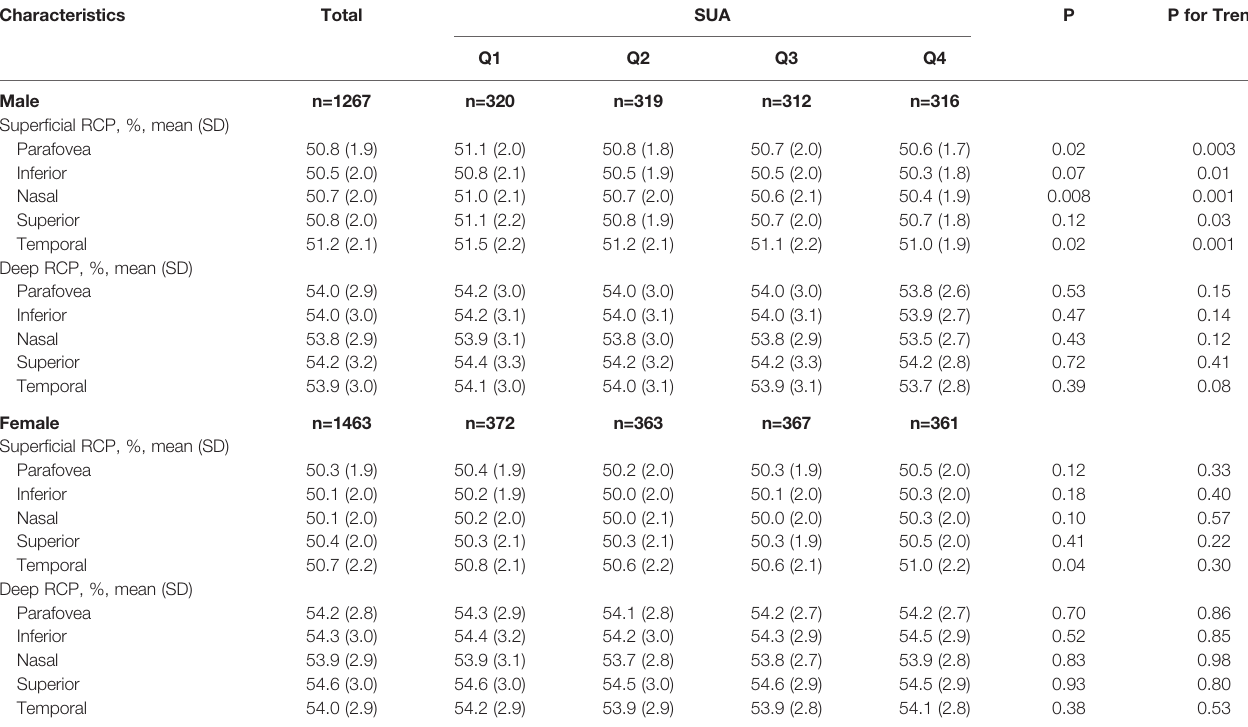
TABLE 2 | Ocular characteristics of participants by serum uric acid quartiles in males and females. Characteristics